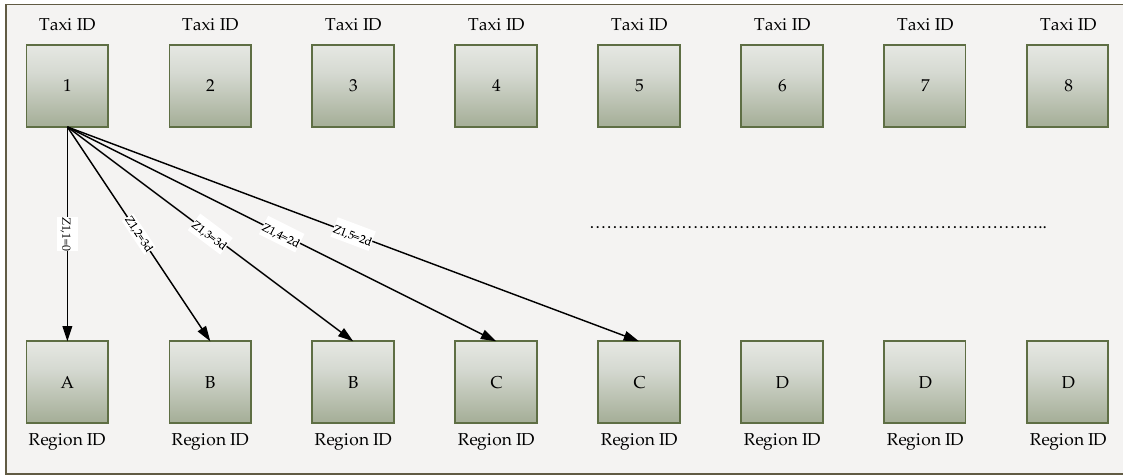
Figure 5. Scenario of the bipatite